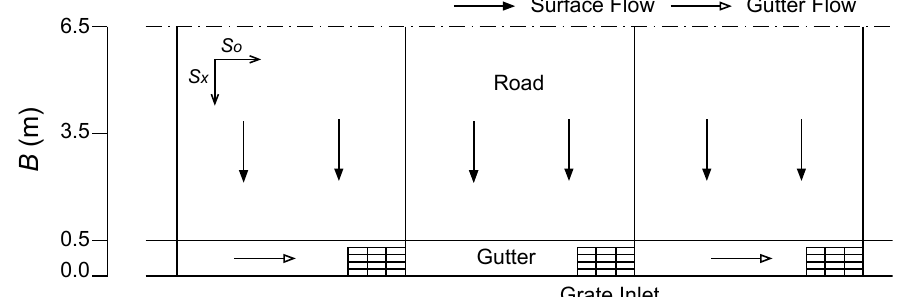
Figure 2. Schematic of a rectangular basin ( S o : longitudinal slope of the road, S x : transverse slope of the road, and B : road width).